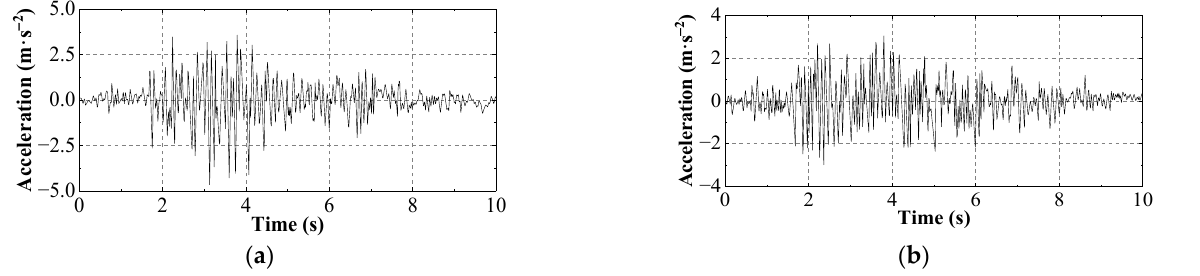
Figure 7. Detailed plot of the 2D FE model of the Koyna dam.